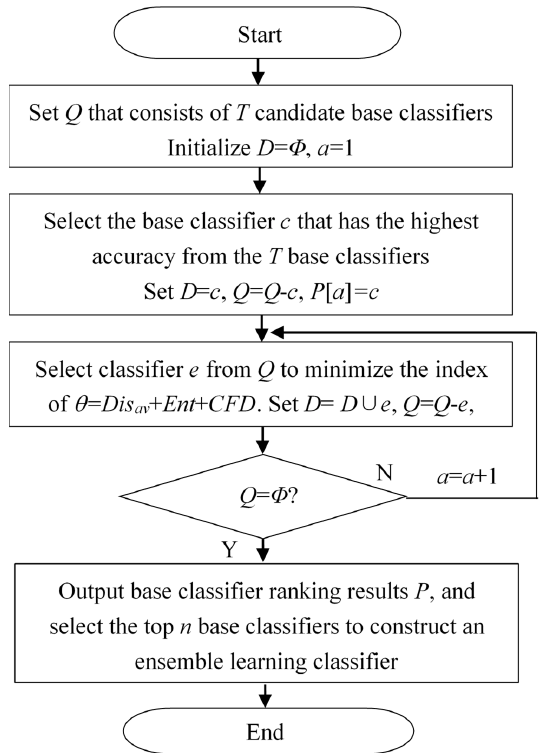
Figure 7. Flowchart of the proposed classifier selection method.